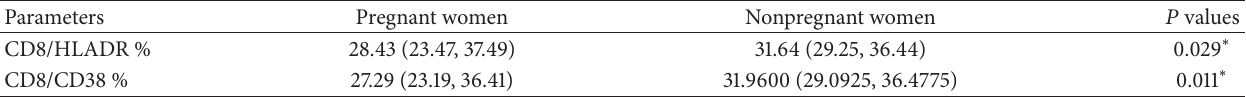
Table 2: Activated CD8T cell percent counts in the study groups (data are median (interquartile range)).